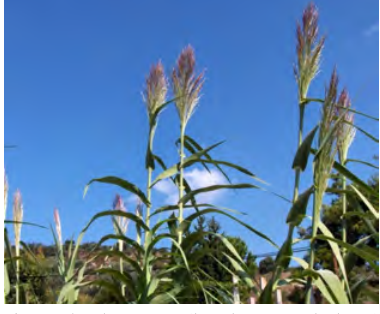
Figure 4. Phragmate(local emerged plant )